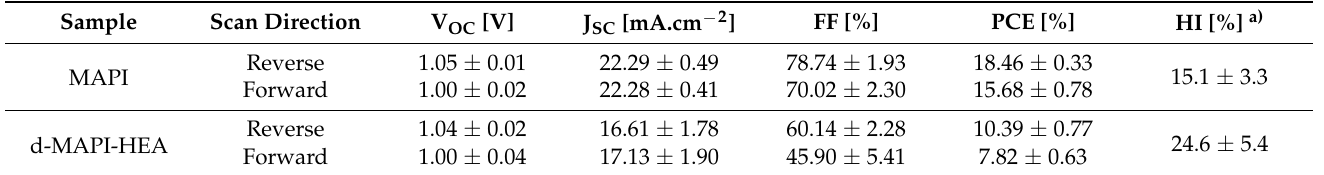
Figure 3. ( a ) J-V curves of best MAPI and d-MAPI-HEA devices. ( b ) Stabilized efficiency of best MAPI and d-MAPI-HEA devices (the applied voltages are 0.87 V and 0.74 V, respectively). ( c ) EQE spectra (left) with integrated J SC (right) of best MAPI and d-MAPI-HEA devices. The arrows point out the Y-axis to read. Table 1. Average photovoltaic J-V parameters with standard deviation of MAPI and optimized d-MAPI-HEA (x = 0.13).